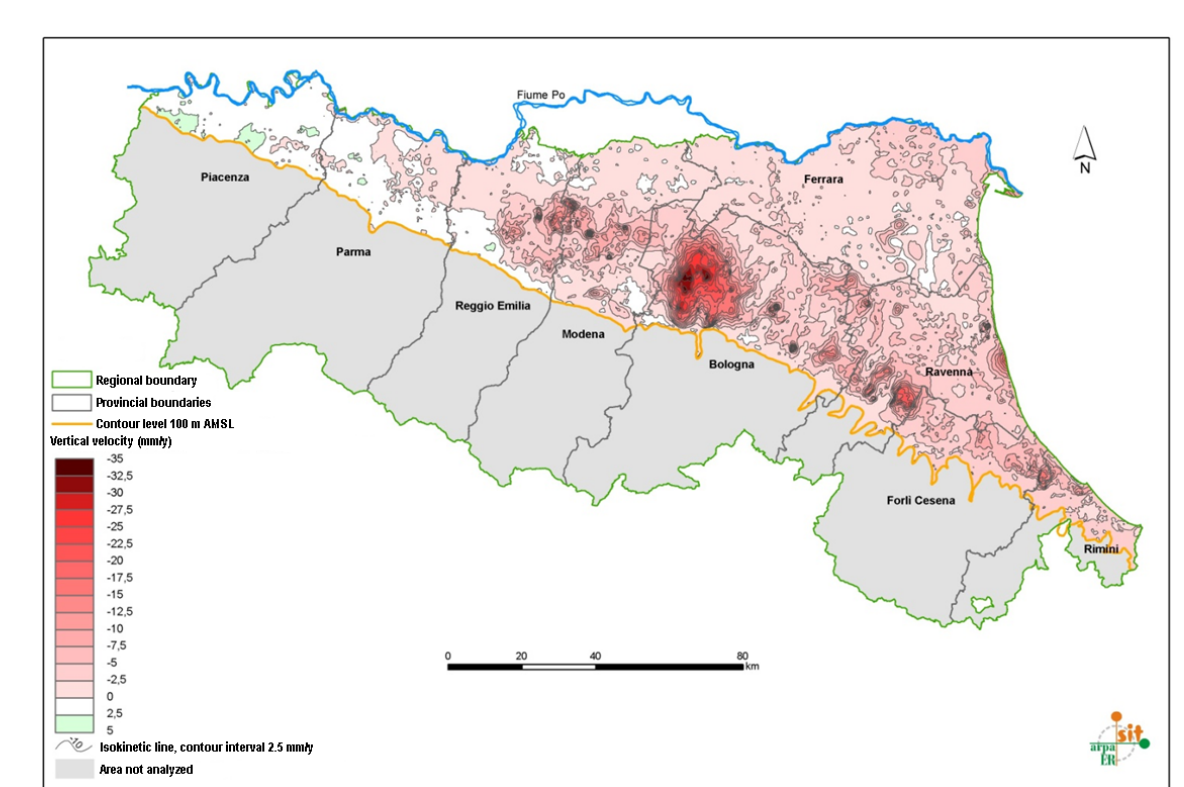
Figure 6. Subsidence map (mmyear − 1 ) for the period